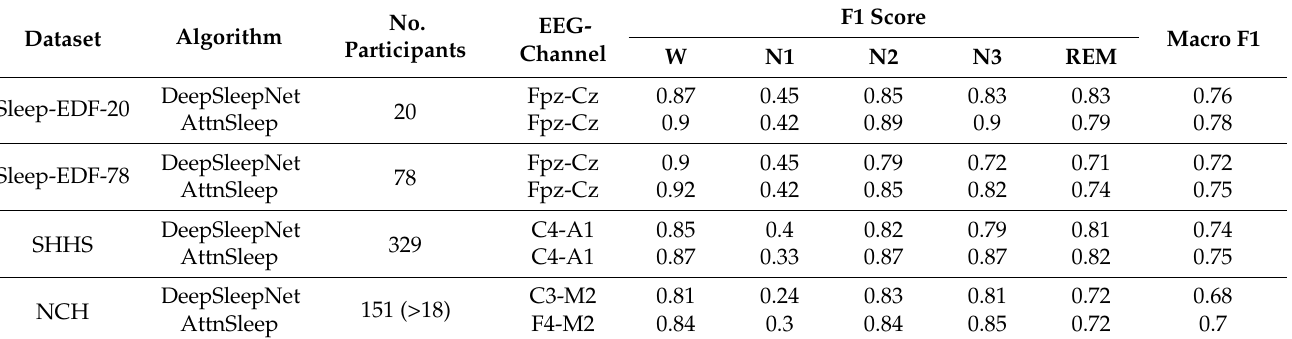
Table 3. Comparing NCH dataset (adult part) to the other sleep datasets in performing sleep stage scoring using DeepSleepNet and AttnSleep